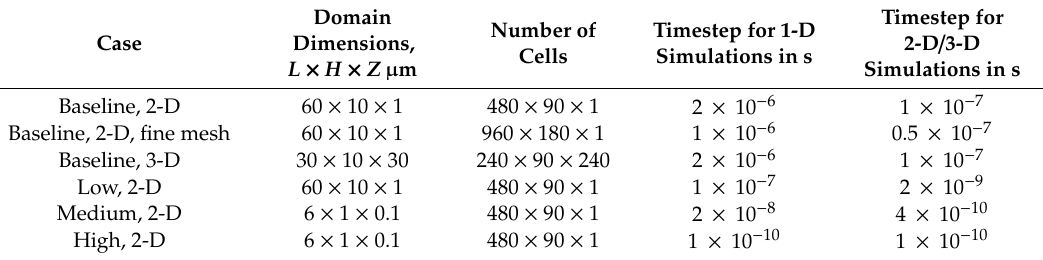
Figure 3. Zoom-in of computational grid near membrane. Table 2. Details of computational grids and timestep.